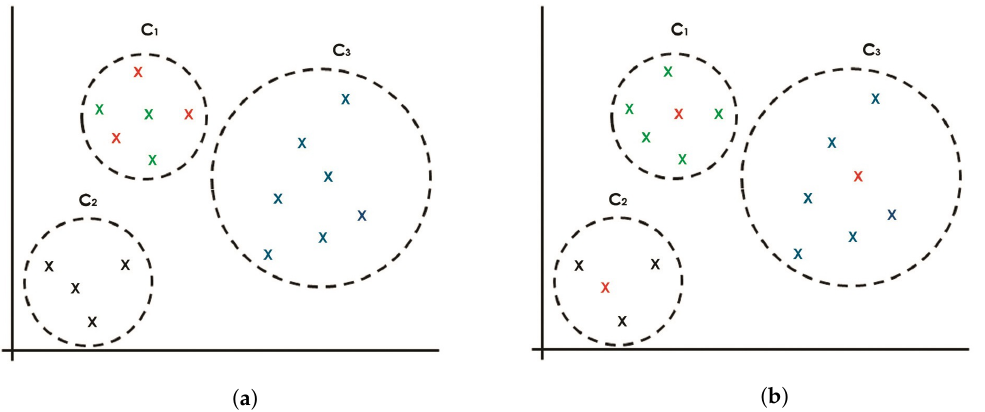
Figure 1. Current seeding approach with random seeds for three clusters: C 1 , C 2 , and C 3 . ( a ) Random seeding approach, which may result in three seeds from the same cluster. ( b ) Random seeding approach, which may result in seeding objects that represent the three clusters equally.